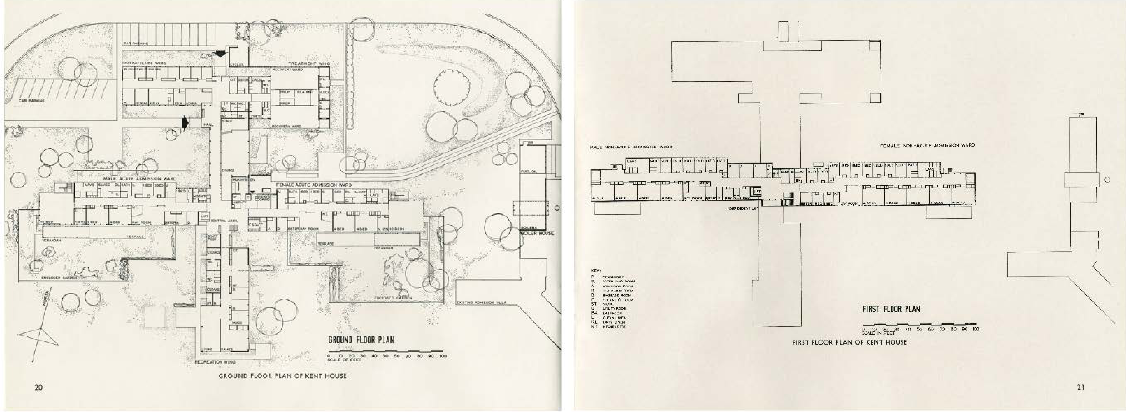
Figure 4. Post-war Admission Villa, Fulbourn Hospital, Cambridge, Cambridgeshire, floor plans, 1964 (Source: ‘Programme for the opening of Kent House new admission unit, 1964’, pp. 20–1, KHF/6/2/9, Cambridgeshire Archive Services, Ely, Cambridgeshire,